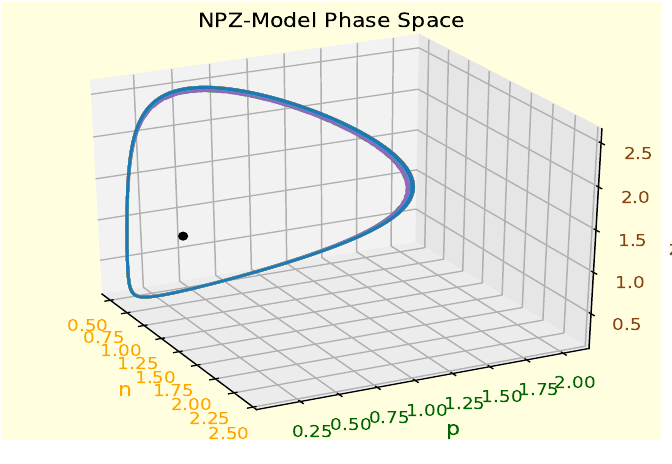
Fig. 3: Emerging limit-cycle after Hopf bifurcation ( S = 4 ) . It is the convergence of 11 trajectories after a transient time of 8000 . The black dot indicates the unstable